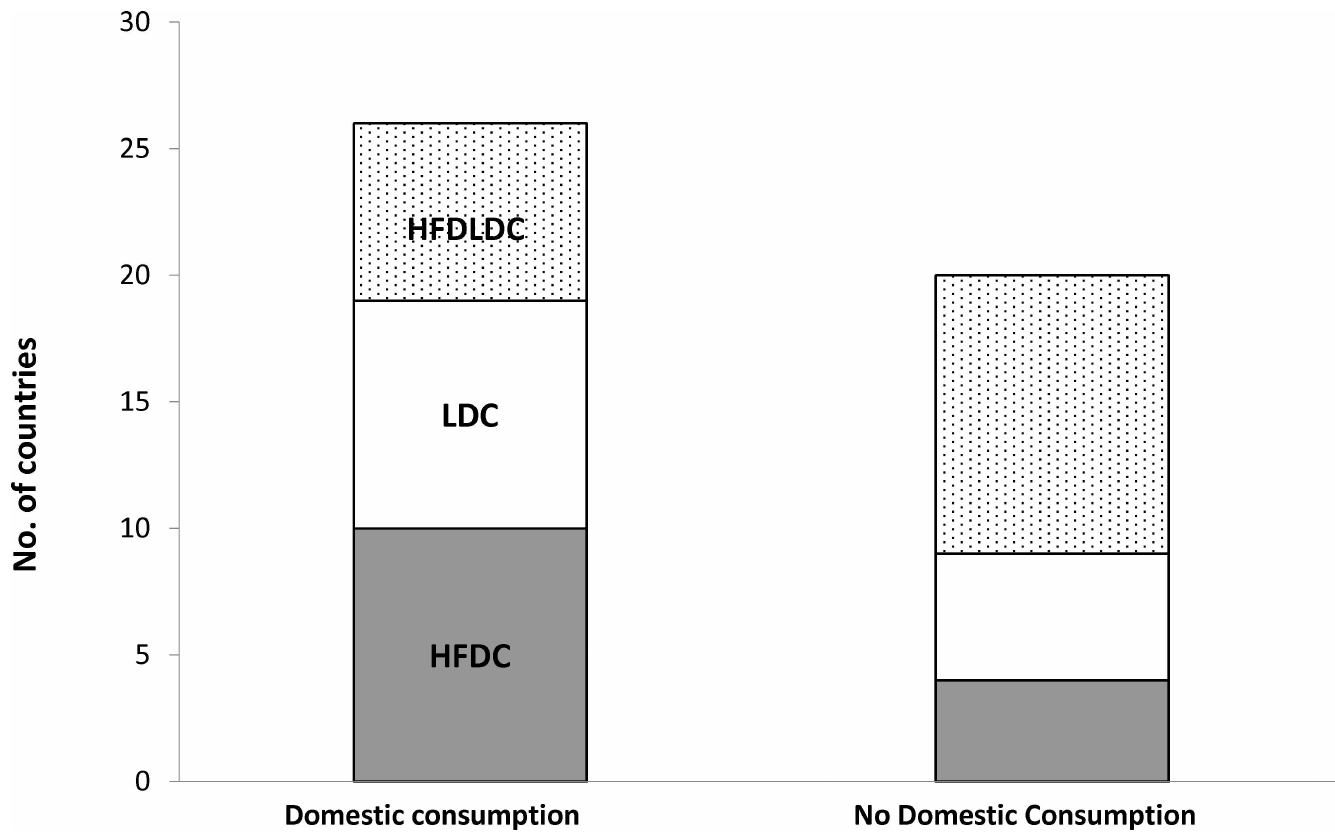
Fig 1. Total number of countries that use straddling species for domestic consumption, broken down according to least developed (LDC), high fish dependent (HFDC), and high fish dependent LDCs